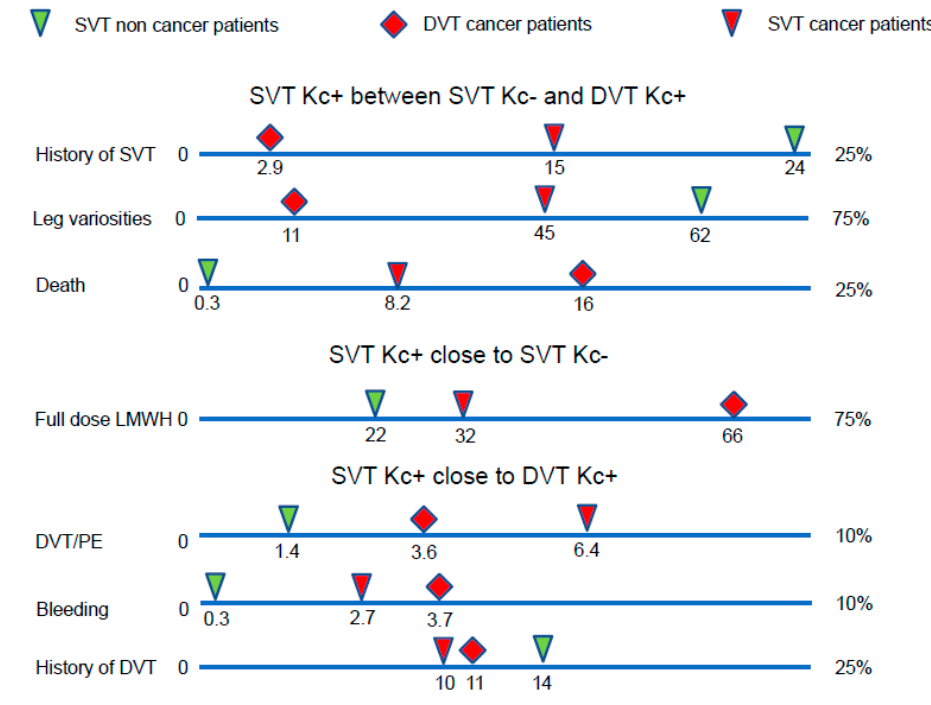
Figure 1. The outcome of SVT in cancer patients was worse than SVT in non-cancer patients, but better than DVT in cancer patients. DVT: deep vein thrombosis, Kc: cancer, LMWH: low molecular better than DVT in cancer patients . DVT: deep vein thrombosis, Kc: cancer, LMWH: low molecular weight heparins, PE: pulmonary weight heparins, PE: pulmonary embolism.